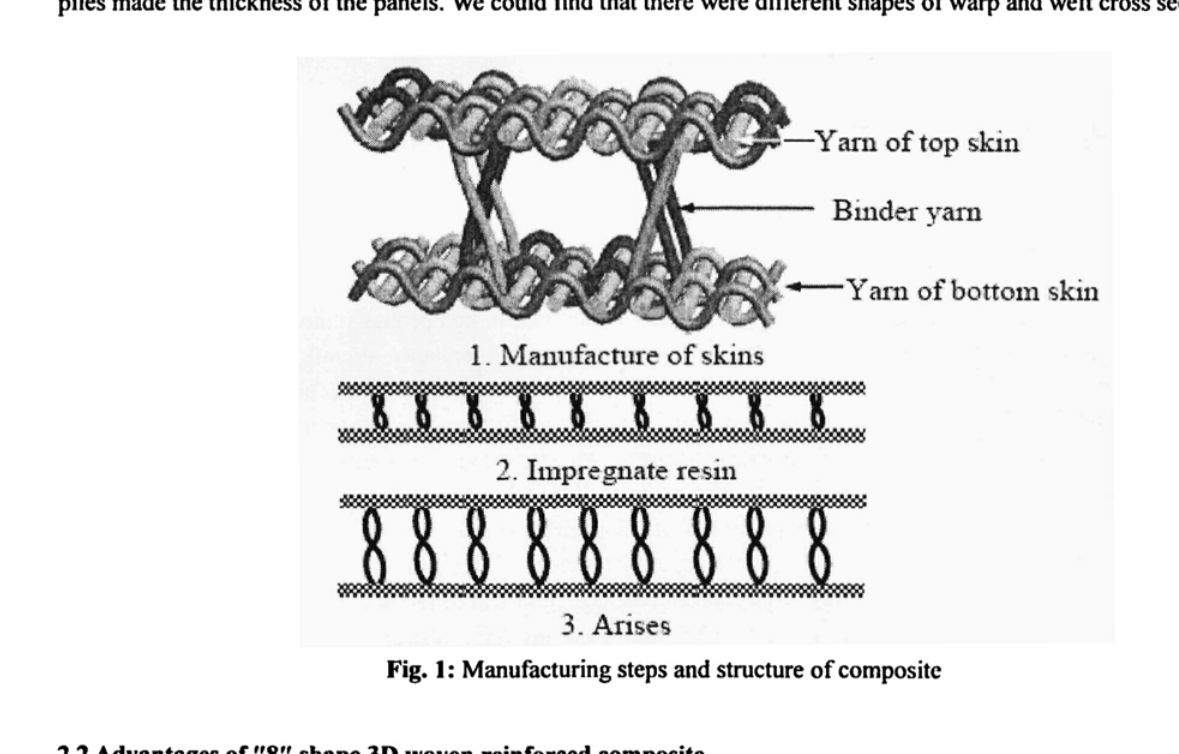
Fig. 1: Manufacturing steps and structure of